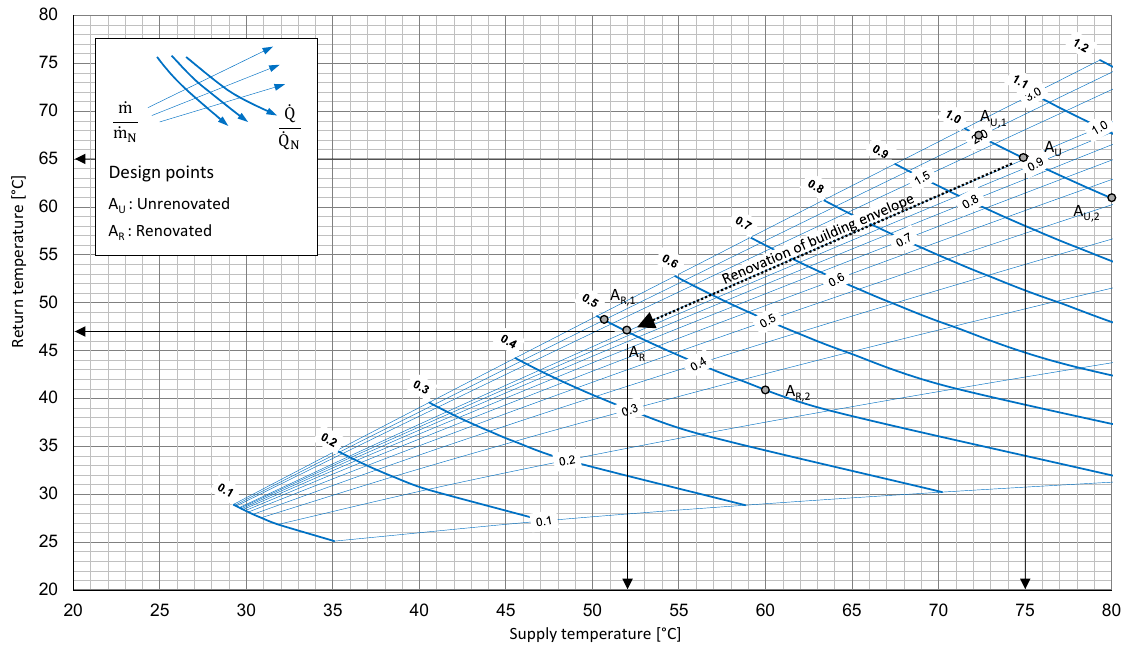
Figure A2. Planning tool for temperature reduction potential for radiators.